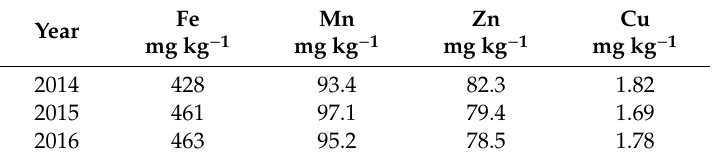
Table 2. Soil abundance in the micronutrients at the depth of 0–20 cm in